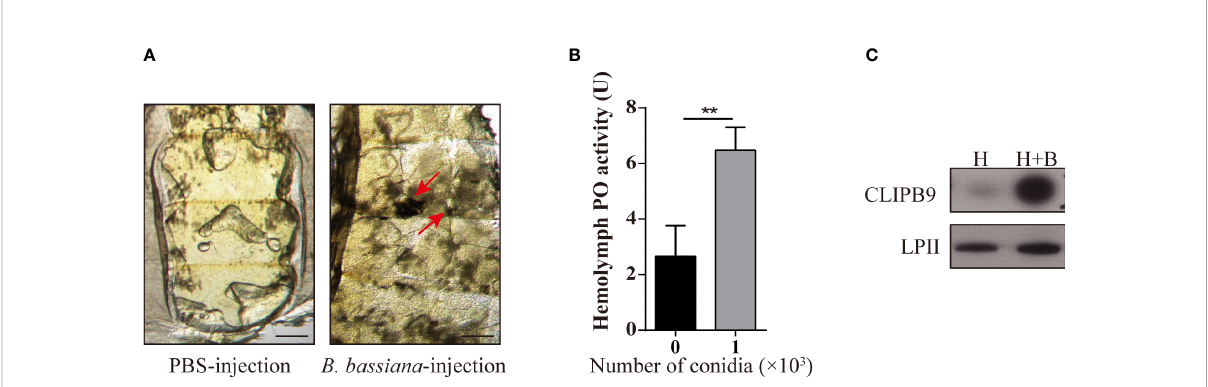
FIGURE 1 B. bassiana induced melanin synthesis is mediated by Ae. aegypti CLIPB9. (A) Mosquitoes appeared melanization after infected with B. bassiana . The melanotic masses were found in mosquitoes infected with B. bassiana but not in control PBS treatment. Abdominal images were observed under an OLYMPUS SZX16 microscope. The red arrows indicate the melanotic masses. Scale bars, 200 m m. (B) PPO in hemolymph was activated by B. bassiana conidia. PO activity was detected after 10-fold dilution of fresh hemolymph. The hemolymph with the addition of 1 × 10 3 conidia was signi fi cantly activated compared to the hemolymph without the addition of conidia. The bars represent the mean ± SEM (n = 3). **P < 0.01. (C) Immunoblotting analysis of CLIPB9 expression in hemolymph after B. bassiana infection. H, mosquito hemolymph was uninfected. H + B, mosquito hemolymph infected with B. bassiana . Anti-LPII antibody was used as the loading